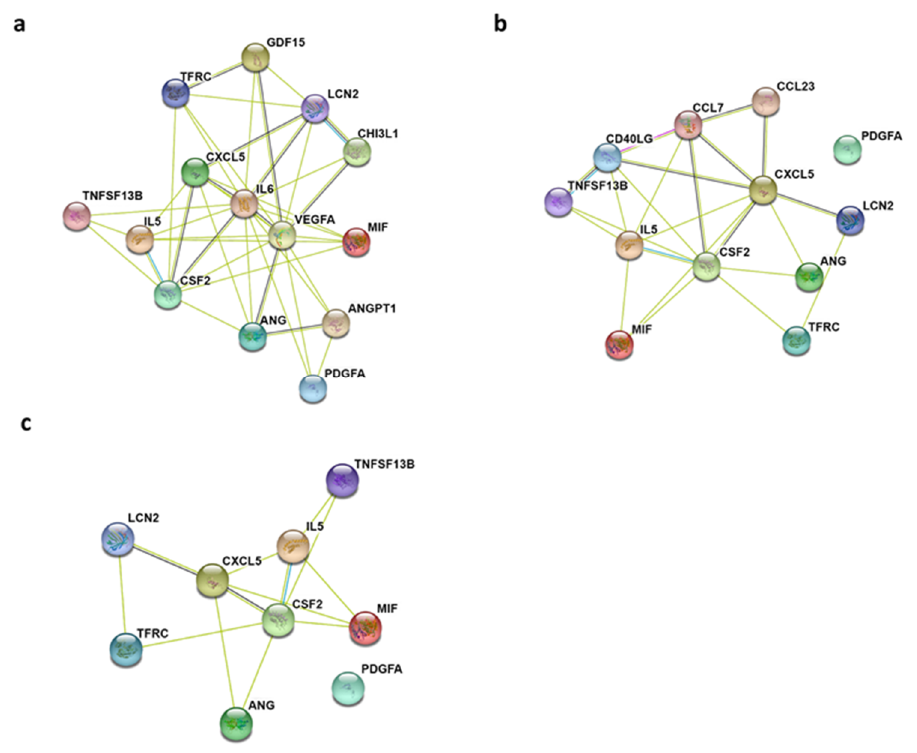
Figure 4. Protein-protein interaction network between differentially expressed cytokines in ovarian cancer–macrophage co-cultures. ( a ) Epi 24 hrs ( b ) NE 24 hrs and ( c ) shared cytokines between Epi and NE 24 hrs treatment. Each node represents a protein, and the edges linking nodes represent known interactions between the two proteins.